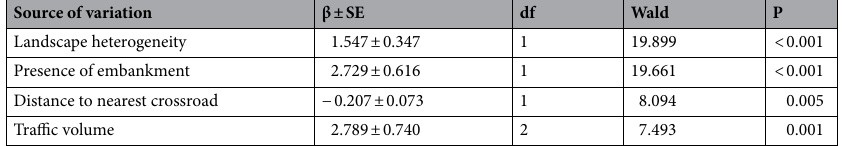
Table 6. Results of the GLMM fitted to differentiate between hare–vehicle collision points and random points without collisions. Model coefficients are shown with their standard error and Wald significance test. P values were considered to be significant at P <